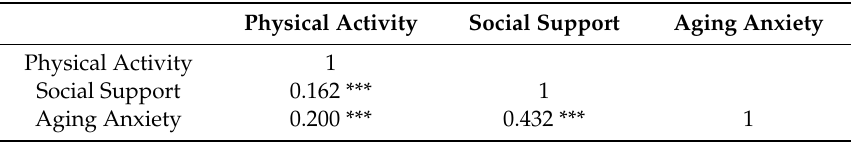
Table 6. Correlations between variables.